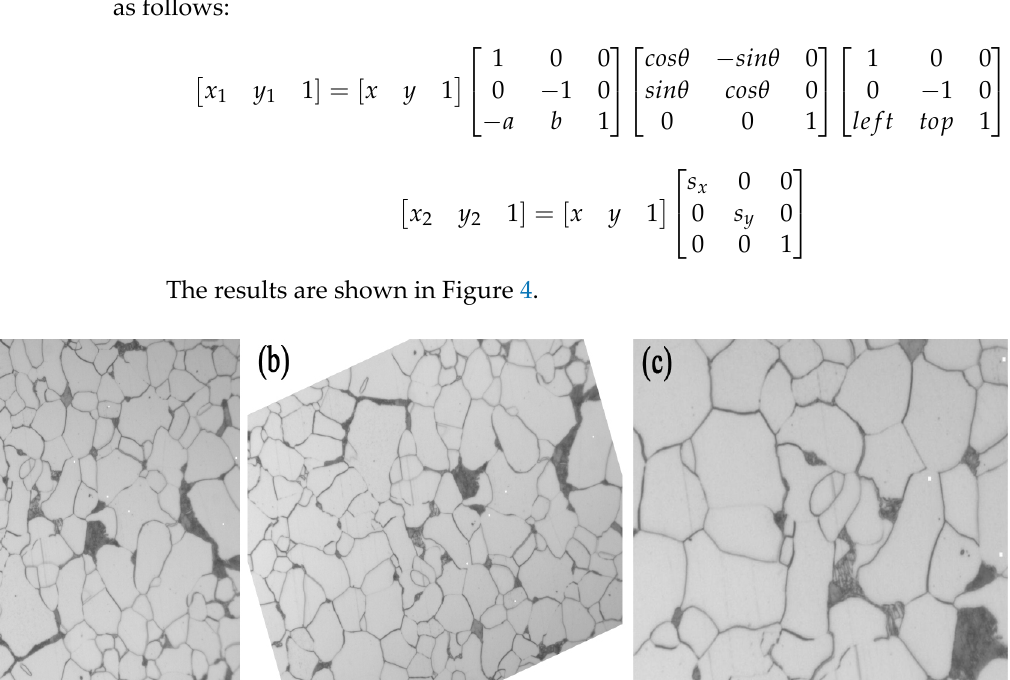
Figure 5. Random erasing images (Original ( a ), Erased ( b )).